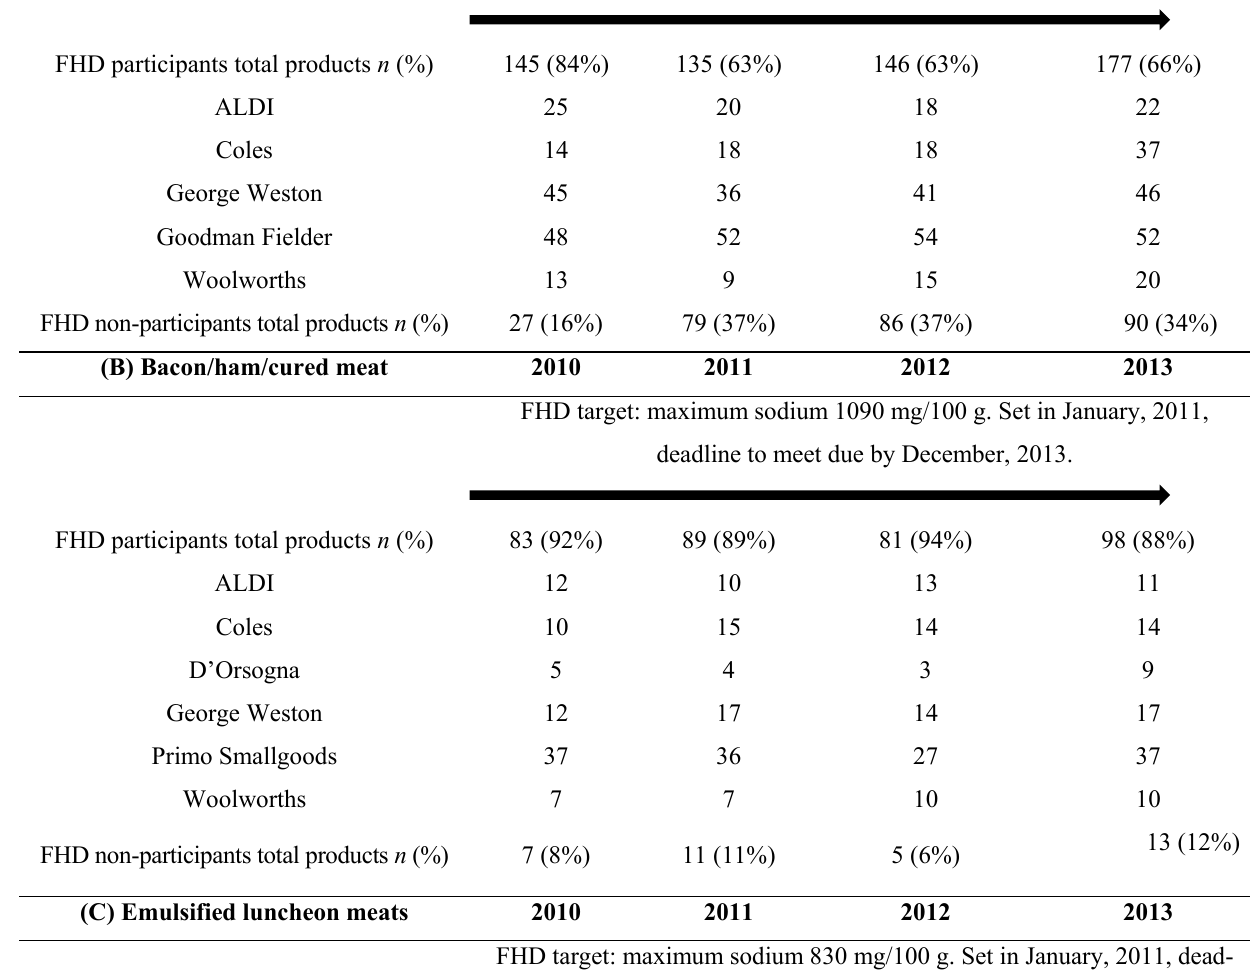
Table 1. The Food and Health Dialogue (FHD) targets and products included for: ( A ) bread; ( B ) processed meats (bacon/ham/cured meats); ( C ) processed meats (emulsified luncheon meats); ( D ) ready-to-eat breakfast cereals; for all FHD participants, all FHD non-participants products’ and individual FHD participants . (A) Bread 2010 2011 2012 2013 FHD target: maximum sodium 400 mg/100 g. Set in May, 2010, deadline to meet due by December, 2013. FHD participants total products n (%)